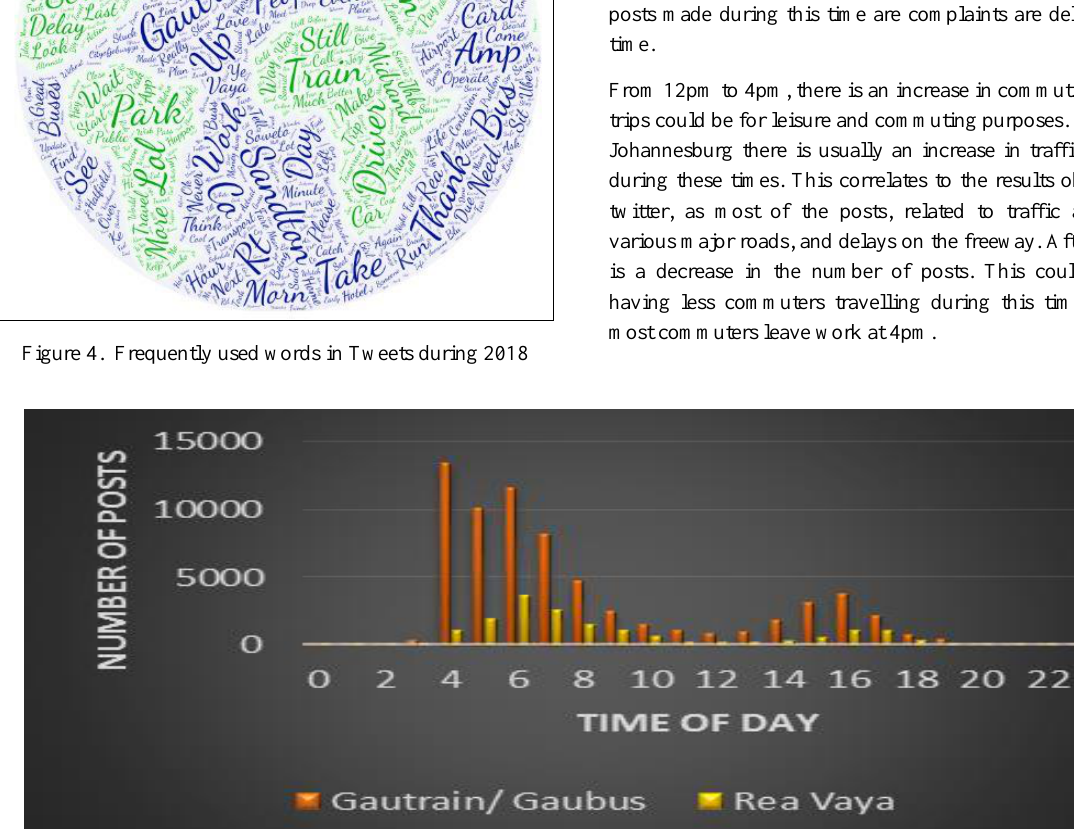
Figure 5. Concentration of trips per